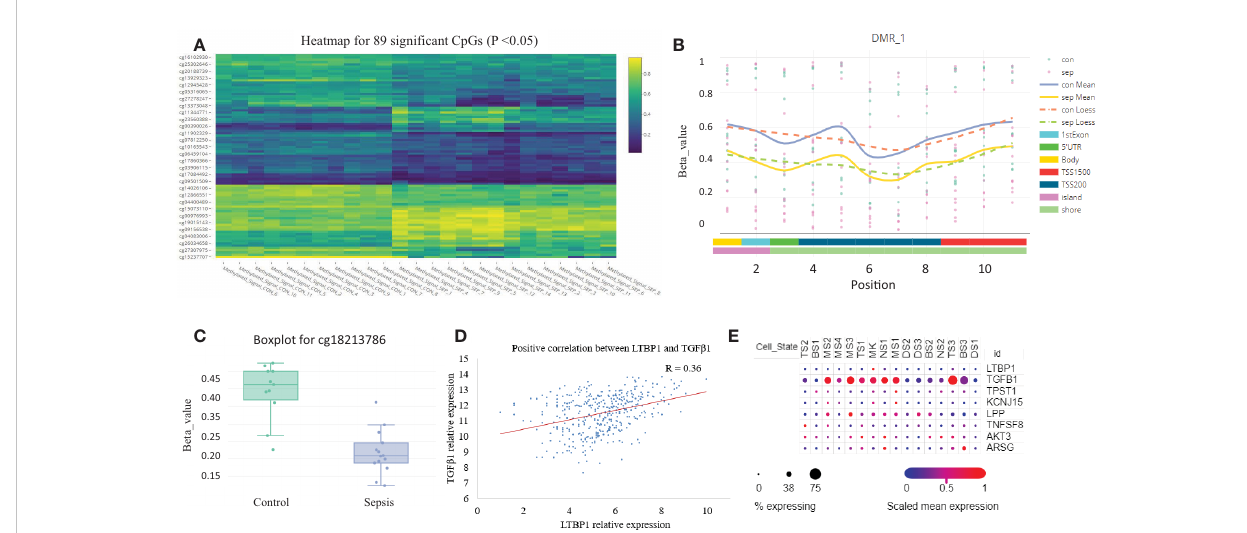
FIGURE 6 DNA methylation is altered in sepsis blood. (A) Heatmap plot for the 89 differentially methylated probes with adjusted P <0.05. (B) A representative plot for the hypomethylated region on chromosome 2. (C) Boxplot for probe cg18213786 which represents down-regulated methylation signal in gene LTBP1 (P =0.03). (D) The correlation scatter plot shows the positive expression relationship between LTBP1 and TGF- b 1 (P =2E-11). (E) The expression dot plot shows cell type-speci fi c expression of LTBP1 and TGF- b 1. TS, T cell subclusters; NS, NK cell subclusters; MS, monocyte/ macrophage subclusters; MK, megakaryocyte subclusters; DS, dendritic cell (DC) subclusters; BS, B cell